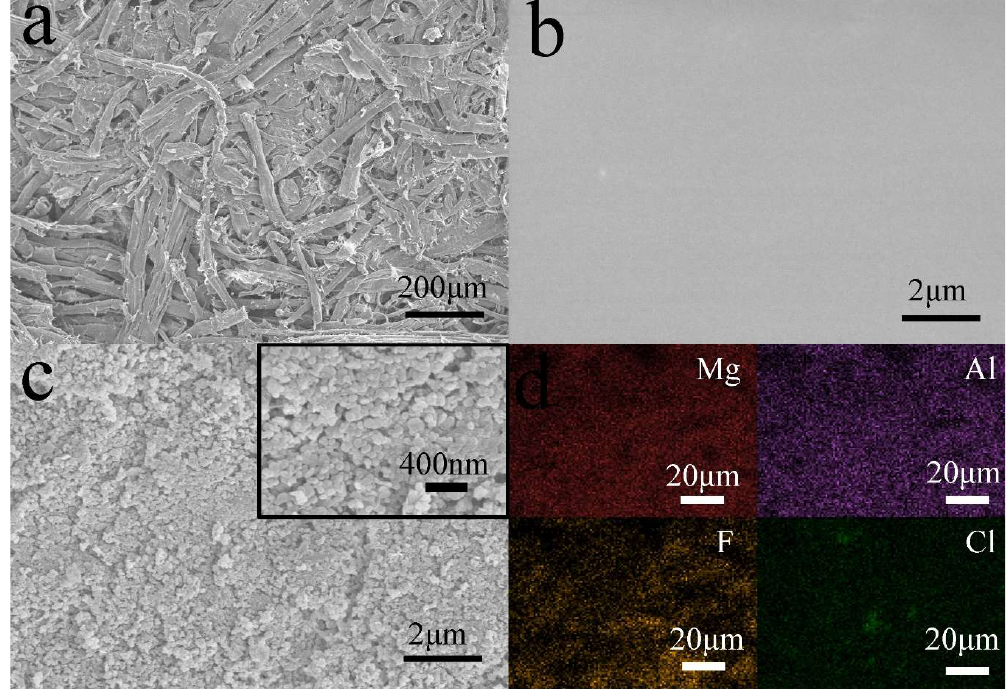
Figure 4. SEM images of MDFs ( a ); MDFs coated with PDMS ( b ); MDFs coated with